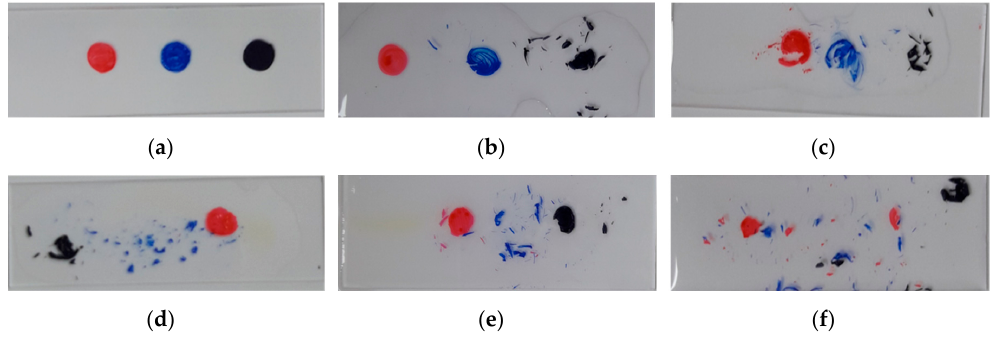
Figure 2. Anti-pollution characteristics of the functional coating film according to the annealing gas, ( a ) is naturally dried, ( b – f ) are annealed with H 2 , N 2 , Ar, O 2 , and in a vacuum, respectively.